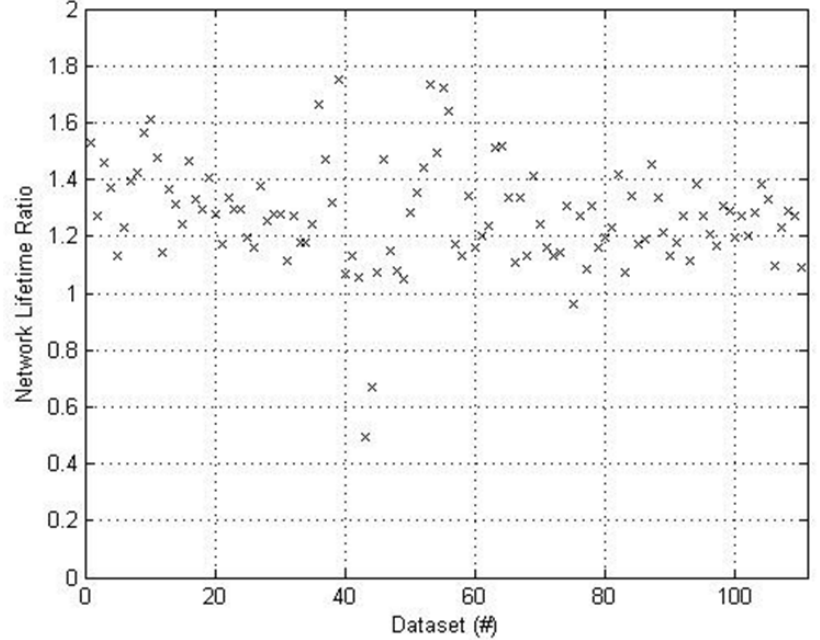
Figure 8. Improvement in Network Lifetime for M = 100 vs. M = 0. Note that the proposed system provides an average gain of approximately